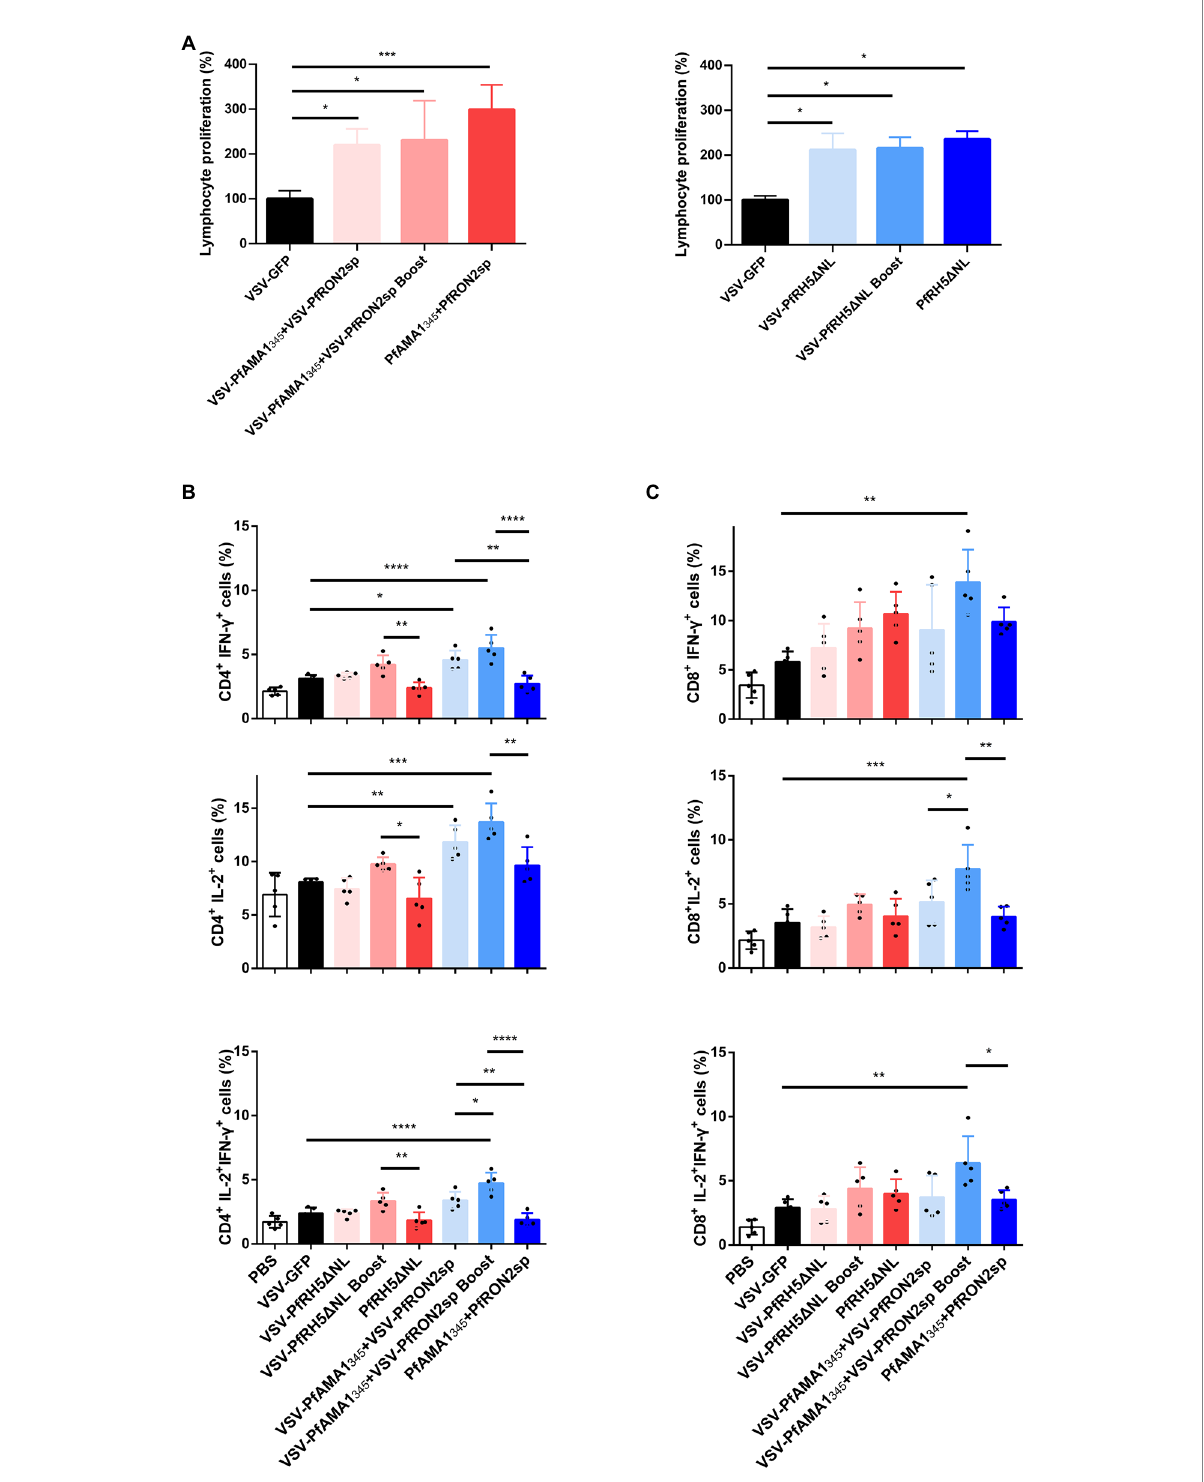
FIGURE 4 Antigen-specific cellular immune responses induced by immunization with VSV-based vaccines. Spleen cells were collected from immunized mice after 5 weeks of immunization (A) Splenic lymphocyte proliferation was assessed using MTT assay after stimulation with 5 μ g/ml PfAMA1 345 + PfRON2sp or PfRH5 Δ NL proteins (peptides). VSV-GFP was used as the control. (B,C) The frequency of CD4 + and CD8 + T cells secreting IFN- γ or IL-2 alone was determined by flow cytometry after stimulation with 5 μ g/ml PfAMA1 345 + PfRON2sp mixture or PfRH5 Δ NL proteins (peptides) in vitro for 24 h. Treatment with PMA (50 ng/ml), ionomycin (1 μ g/ml), and bafilomycin A (1 μ g/ml) for 6 h. The frequency of CD4 + and CD8 + T cells secreting IFN- γ and IL-2 were determined by flow cytometry after the same stimulation with proteins (peptides) and treatment with PMA, ionomycin, and bafilomycin A. Error bars indicate SD. One-way AVONA was used to perform statistical analysis.* p < 0.05, ** p < 0.01, *** p < 0.001 and **** p <